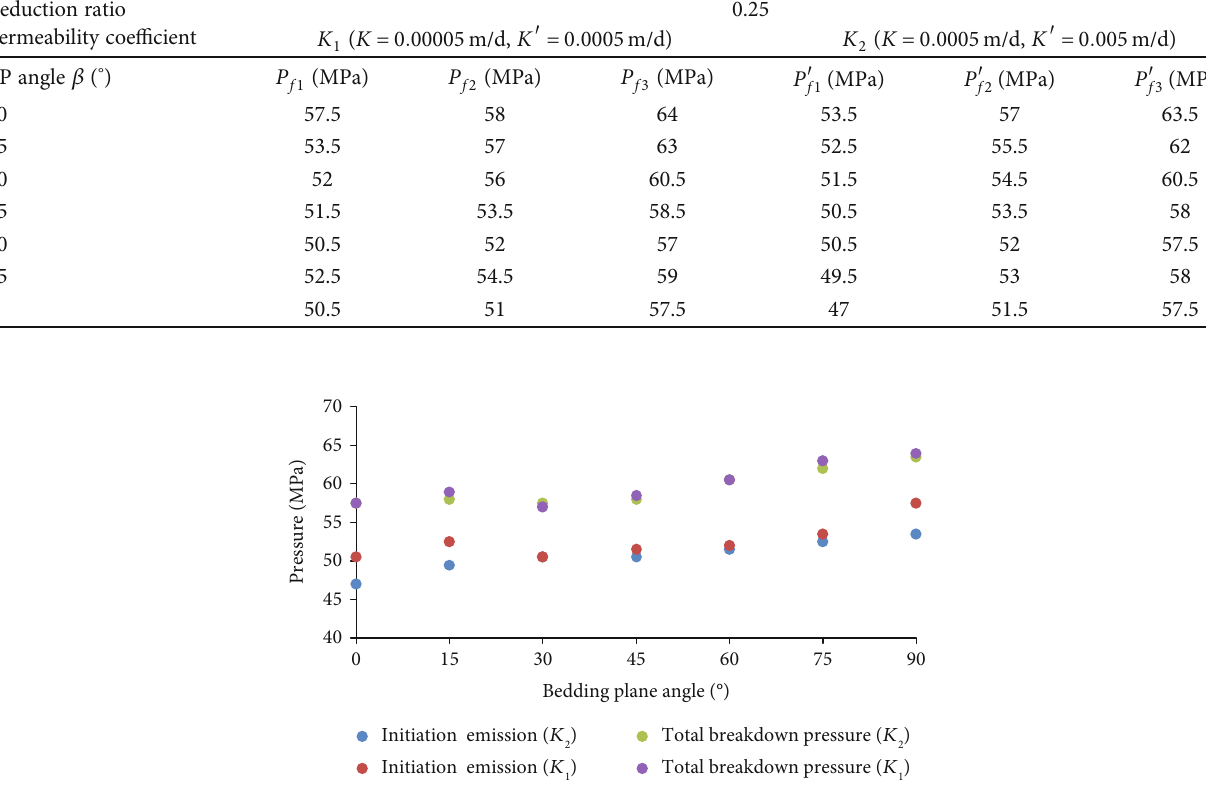
Figure 10: Initiation pressures and total breakdown pressures acquired by pore water pressure nephogram under di ff erent BP models.